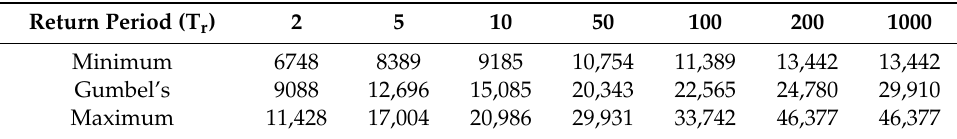
Table 2. Classification of instantaneous discharges (m 3 / s) at Karnali Chisapani obtained using